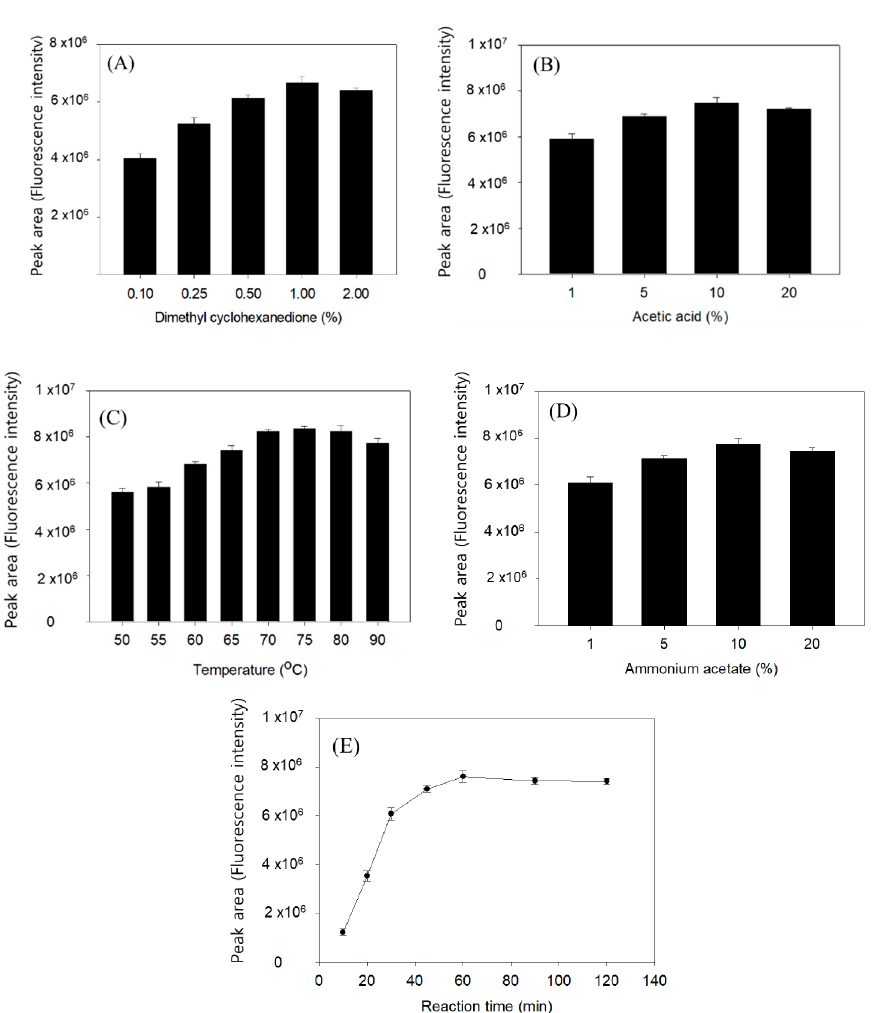
Figure 1. Scheme of sphingosine-1-phosphate lyase (S1PL) activity assay using HPLC–FLD analy- sis .